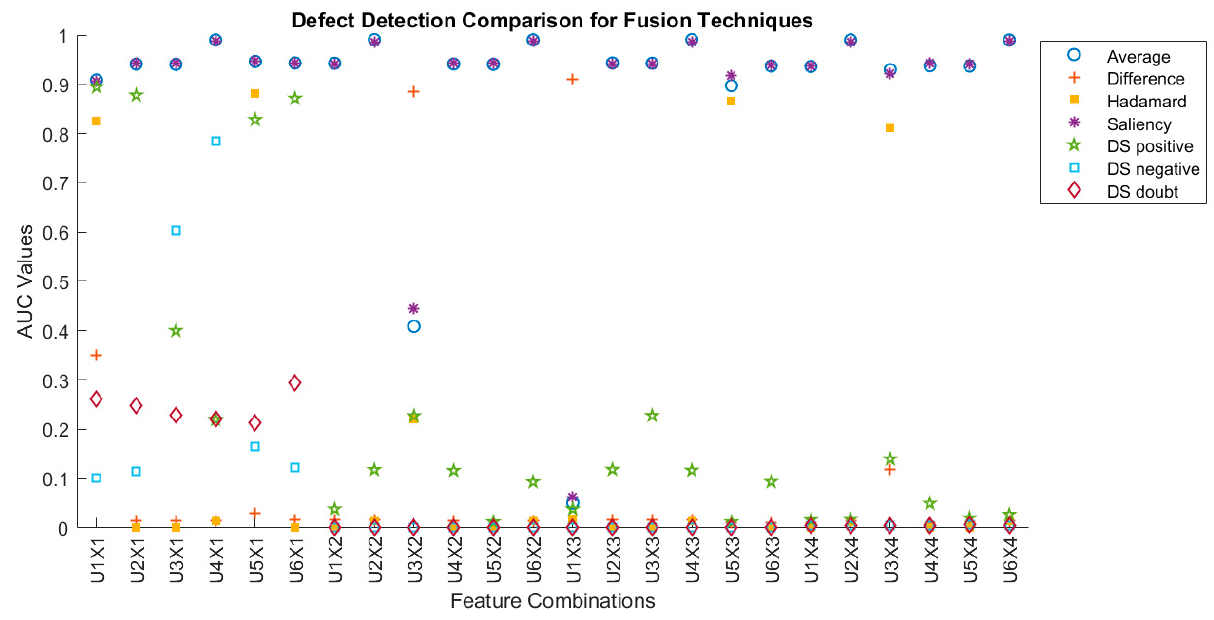
Figure 15. Evaluation of results using receiver operating characteristics (ROC) curve.